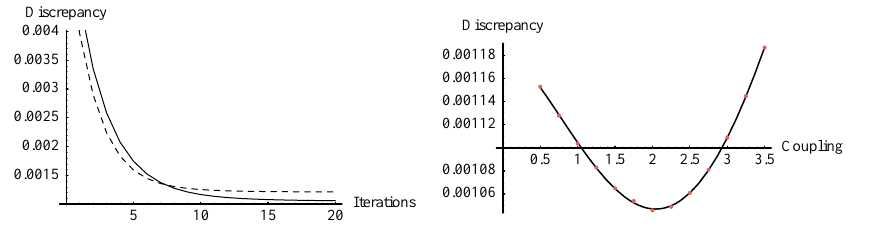
FIG. 3. Left: convergence for the two cases of Fig. 2; the solid line is with space charge included. Right (Color): discrepancy (after 50 iterations) versus geometrical coupling.